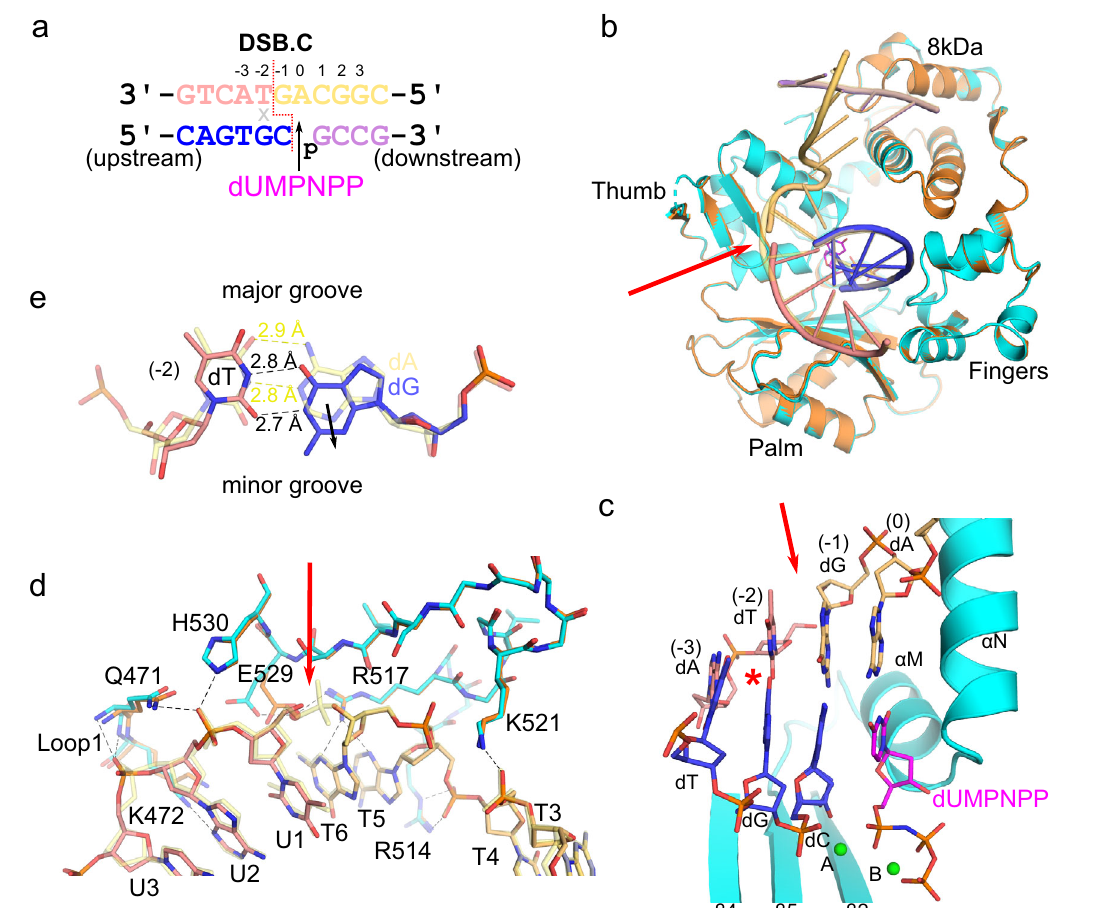
Fig. 7 Pol λ can accommodate mispairs proximal to the break site. a DSB.C substrate, with template strand broken between the − 1 and − 2 positions, co- crystallized with the Pol λ catalytic domain. This substrate also contains a G:T mispair (indicated by gray x) immediately upstream of the break site (red dashed line), at the − 2 position. Upstream (left) template (pink, chain U) and primer (blue, chain P) are annealed separately from the downstream (right) template (pale orange, chain T) and primer (lavender, chain D) strands, and synapsis is mediated by the polymerase. The DSB.C pre-catalytic quaternary complex is formed by the addition of the nonhydrolyzable incoming dUMPNPP (magenta) nucleotide. b Global superposition of the pre-catalytic SSB ternary (orange) and DSB.C quaternary (protein in cyan, DNA and incoming dUMPNPP colored as in a ) complexes. c Structure of the mispaired (red asterisk) pre-catalytic DSB.C substrate bound in the Pol λ active site. Mg 2 + ions are shown as green spheres. d Superposition of the pre-catalytic SSB (protein in orange, DNA template in transparent pale yellow) and mispaired DSB.C (protein in cyan, DNA colored as in a , water molecule as red sphere) complex for comparison of interactions surrounding the DSB break site (red arrow). Hydrogen bonding interactions with the mispaired DSB.C are drawn (black dashed lines). e Superposition of the base pair at the − 2 position in either the SSB (correct base pair, transparent yellow) or mispaired DSB (template dT:primer dG in pink and blue, respectively), with measured hydrogen bonding distances drawn as yellow (correct) or black (incorrect) dashed lines. Solid black arrow indicates subtle shift of the mispaired primer dG toward the minor